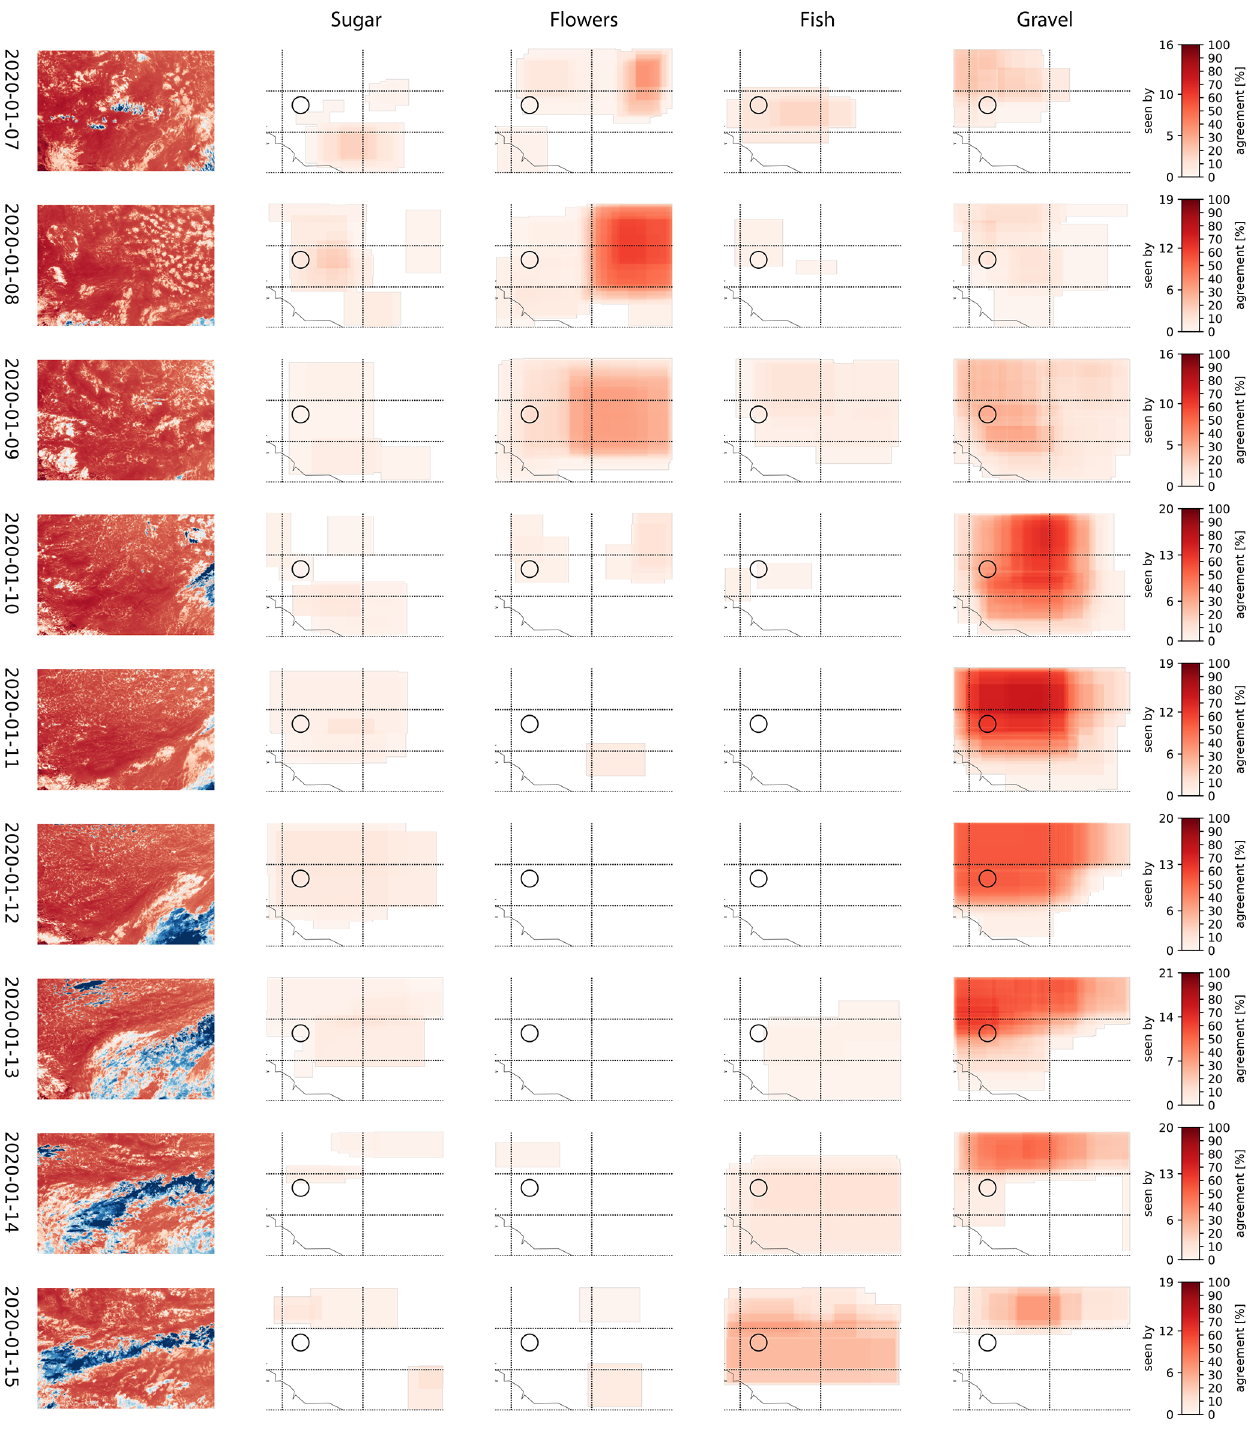
Earth Syst. Sci. Data, 14, 1233–1256,